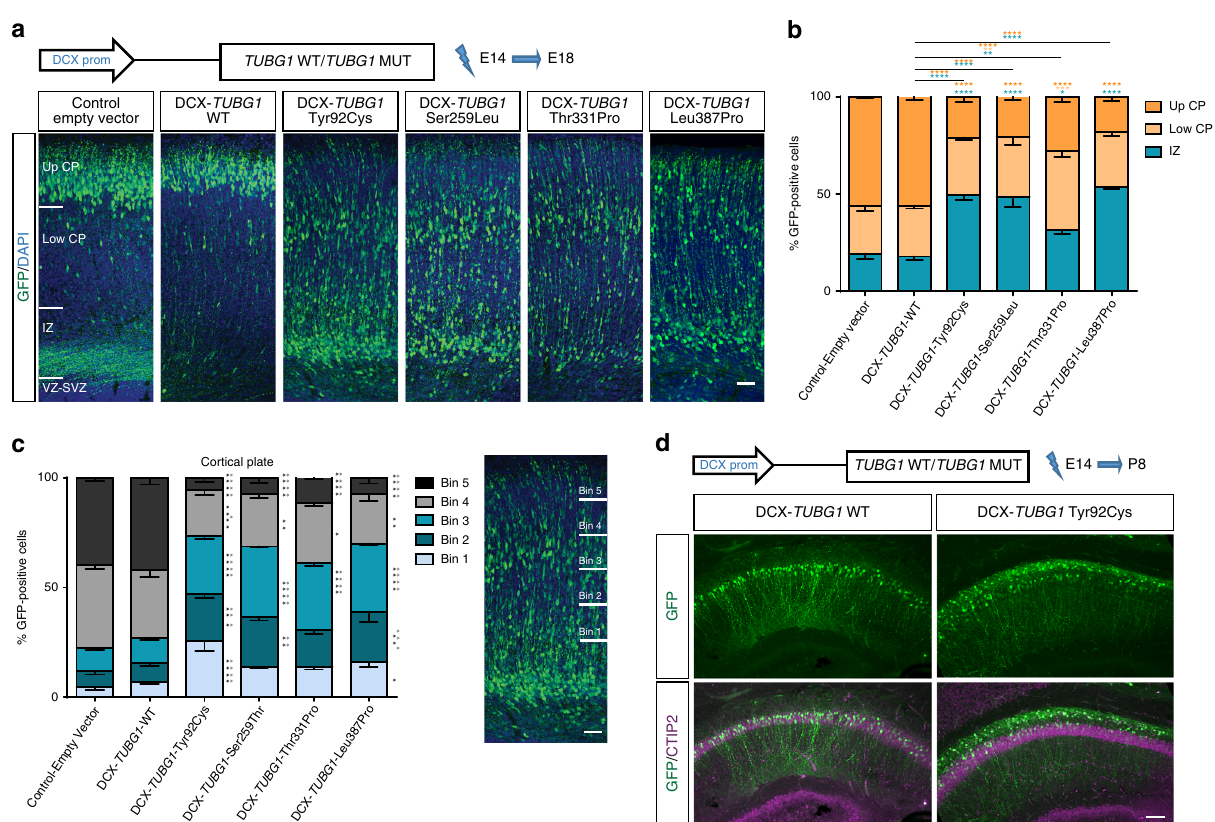
Fig. 2 Neuron-speci fi c expression of TUBG1 mutations affects neuronal positioning a Coronal sections of E18.5 brains electroporated at E14.5 with either a control-empty vector, WT- TUBG1 or one of the four mutated forms of TUBG1 under the control of a neuron-speci fi c DCX promoter and co-electroporated with a reporter construction encoding for GFP under the control of a neuron-speci fi c NeuroD promoter (green). Sections were stained with DAPI (blue). CP, cortical plate; IZ, intermediate zone; VZ/SVZ, ventricular zone/subventricular zone. Scale bar 50 µ m. b Quanti fi cation of fl uorescent neurons in three different regions: up CP, down CP, and IZ for at least four electroporated embryos per group, Two-way ANOVA with Tukey ’ s multiple comparisons test, * p < 0.05, ** p < 0.01, *** p < 0.001, **** p < 0.0001, compared to control-empty vector or wild type TUBG1 overexpression. c Quanti fi cation of fl uorescent neurons in the cortical plate. The image on the right shows the cortical plate divided in fi ve equal sections (bins). Scale bar 50 µ m. GFP-positive cells were counted in each bin for at least four embryos per condition, Two-way ANOVA with Tukey ’ s multiple comparisons test, * p < 0.05, ** p < 0.01, *** p < 0.001, **** p < 0.0001, black asterisks compared to control-empty vector and gray asterisks compared to TUBG1 wild type overexpression. d In utero electroporation of DCX- TUBG1 -Y92C or WT together with GFP (green) in the ammonic neuroepithelium at E14.5. Images show coronal sections of the CA1 region of the hippocampus at P8 counterstained with CTIP2 marker (magenta). Scale bar 150 µ m. Data are represented as mean ± s.e.m. Source data are provided in the Source Data fi